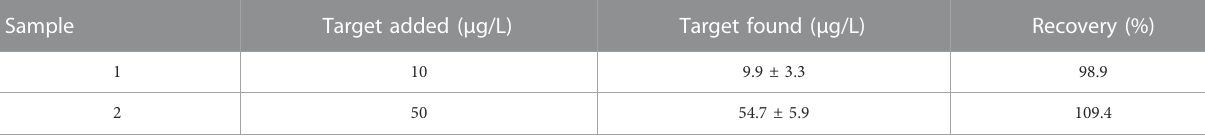
TABLE 2 The recovery tests of malathion spiked in tap water using the current method.